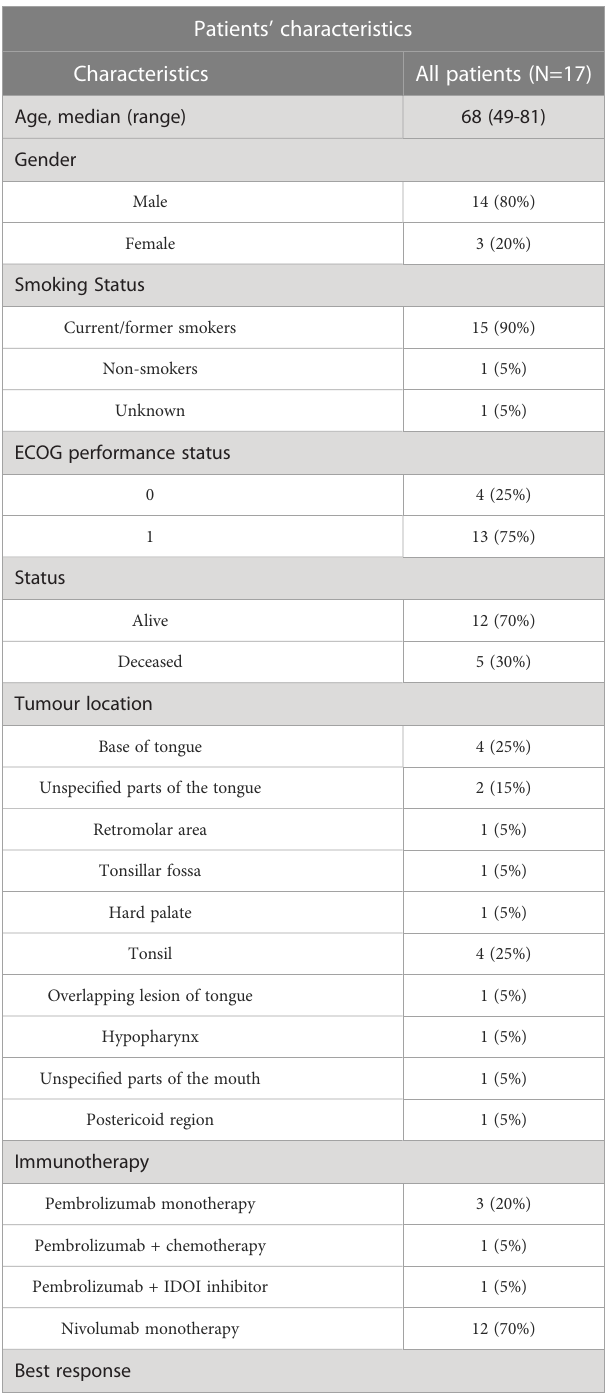
TABLE 1 HNSCC cohort